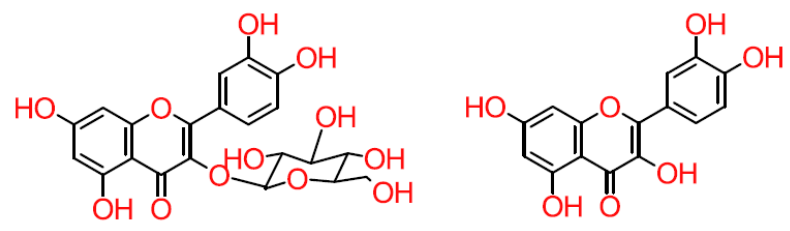
Figure 3. Structure of glycoside and aglycone flavonoids.